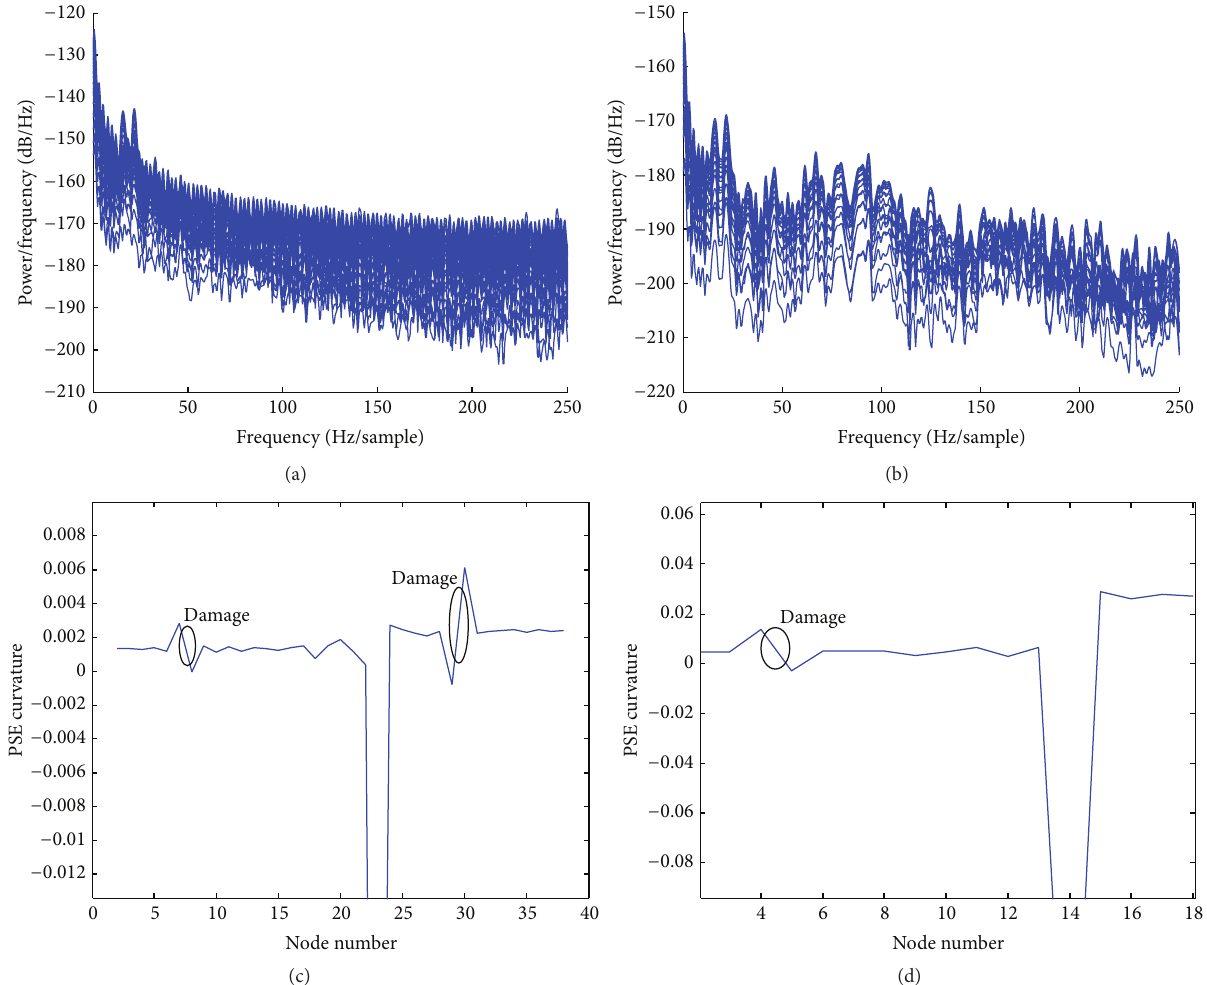
Figure 10: PSE and the curvature curves containing 3% noise: (a) PSE curves of beam 1, (b) PSE curves of beam 2, (c) PSE curvature of beam 1 using the maximum PSEs at the first resonance frequency, and (d) PSE curvature of beam 2 using the maximum PSEs at the first resonance frequency.